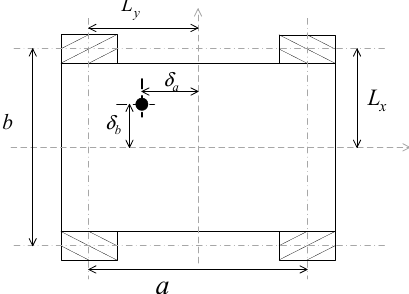
Figure 3. Schematic diagram of the analysis of the robot’s center of gravity position.